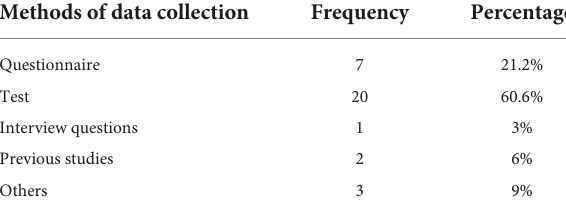
TABLE 4 Distribution of research papers related to uses of virtual and augmented reality in science and math education in Arab countries by ways of collecting data ( n = 33).